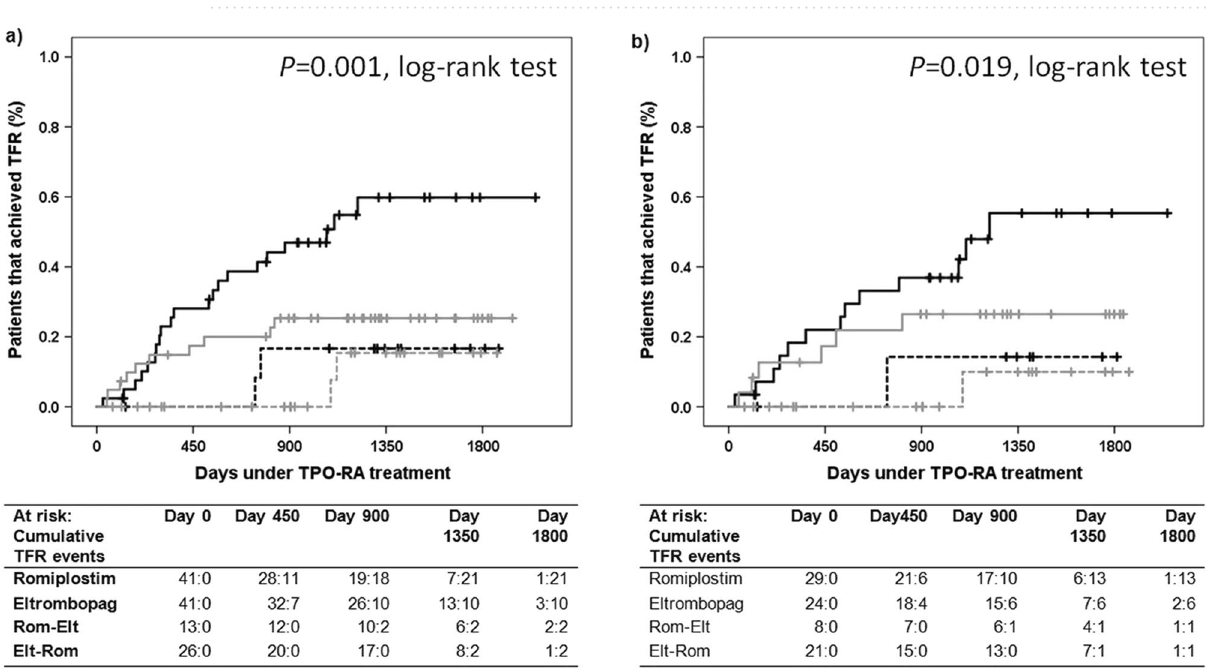
Figure 2. Probability of achieving therapy free responses (TFR). Proportion of patients achieving TFR within the whole cohort (n = 121) included in the study (panel a ), and in those with chronic ITP (panel b ). TFR was defined as the ability of a patient to discontinue TPO-RA as platelet counts > 50 × 10 9 /l for at least 6 months in the absence of any therapies meant to increase platelet counts. Patients who died while on TPO-RA therapy were not included in the study. Solid black line represents patients that received only romiplostim (Panel a , n = 41; Panel b , n = 29). Solid grey line represents patients that received only eltrombopag (Panel a , n = 41; Panel b , n = 24). Dashed black line represents patients that initiated romiplostim and switched to eltrombopag (Panel a , n = 13; Panel b , n = 8). Dashed grey line represents patients that initiated eltrombopag and switched to romiplostim (Panel a , n = 26; Panel b , n = 21). The number of patients under TPO therapy (“at risk”) and the cumulative TFR at time points are presented for each group below each